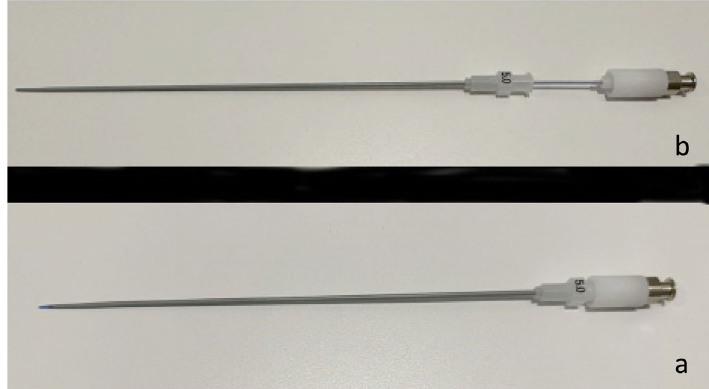
Fig. 5 Micropuncture set (Cook Inc. Bloomington, IL). a shows the dilator and cannula placed together as one unit. b shows the dilator being pushed forward off the stiffened cannula